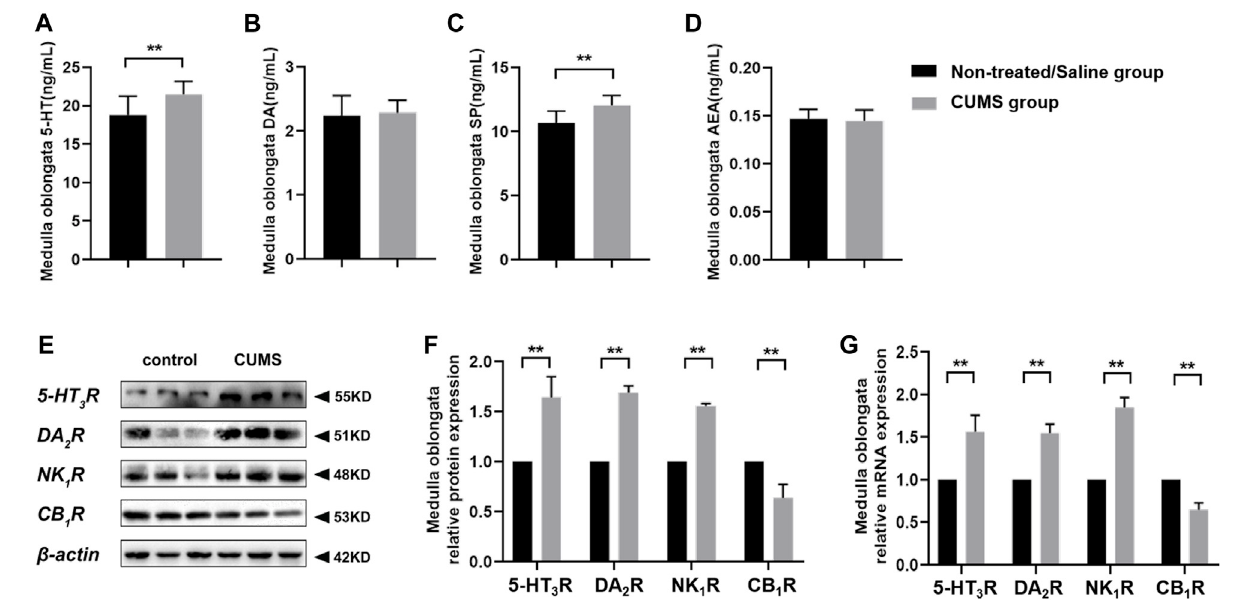
FIGURE3| Chronicstressincreased5-HTandSPlevels,upregulated5-HT 3 R,DA 2 R,andNK 1 Rexpressions,anddownregulatedtheCB 1 RexpressionintheCNS ( n = 10/group). (A – D) Vomit-related neurotransmitter levels in the medulla oblongata. (E) Representative Western blotting bands of vomit-related receptors. (F) Relative protein expression of vomit-related receptors in the medulla oblongata (normalization: experimental group (target protein/housekeeping protein)/control group (target protein/housekeepingprotein)). (G) RelativemRNAexpressionofvomit-relatedreceptorsinthemedullaoblongata(normalization:experimentalgroup(targetgene/ housekeeping gene)/control group (target gene/housekeeping gene)). Data were expressed as mean ± SD. ** p < 0.01 (statistical comparisons between the two groups were performed using the two independent sample